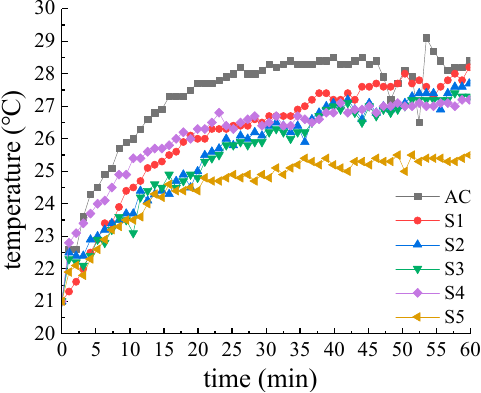
Figure 5. Surface temperature variation curves of specimens.